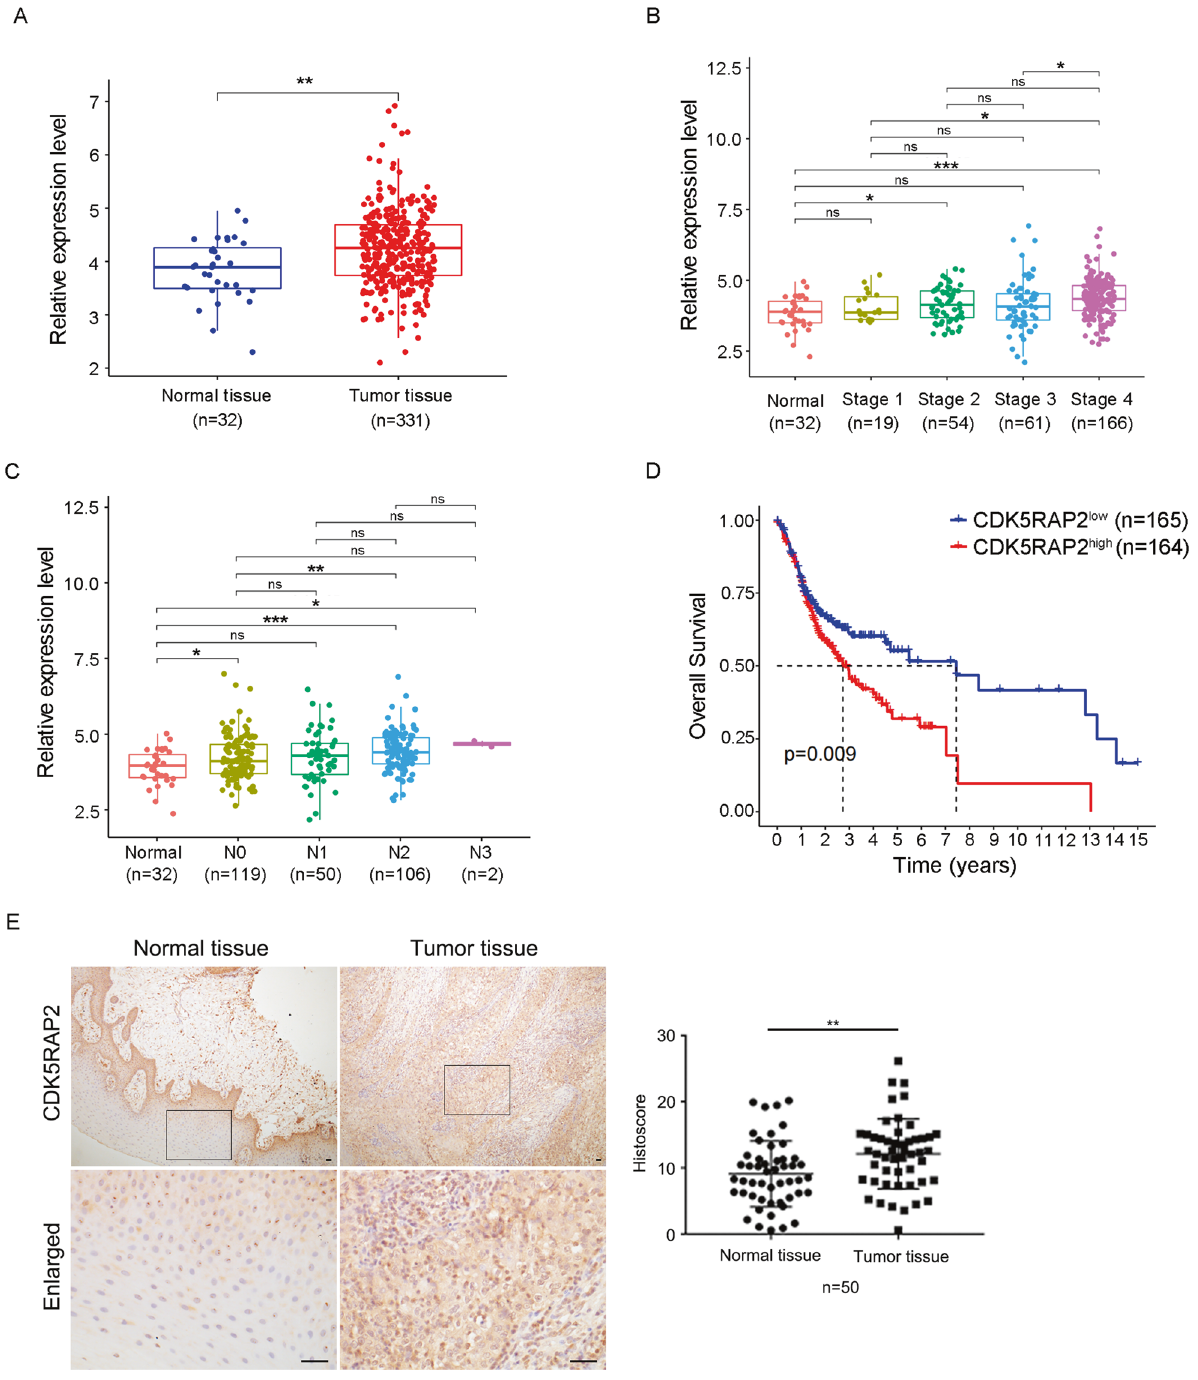
Fig. 1 CDK5RAP2 is upregulated in OSCC. A – C CDK5RAP2 expression in OSCC according to sample types A , cancer stages B , and nodal metastasis status C . D Kaplan – Meier survival analysis of TCGA-OSCC cohorts grouped by CDK5RAP2 expression level. E IHC staining of CDK5RAP2 in OSCC. Rectangular area is enlarged. CDK5RAP2 expression was quanti fi ed using Image J ( n = 50). Scale bars, 20 μ m. Data are presented as means ± SEM; ns no signi fi cance, * P < 0.05, ** P < 0.01, *** P < 0.001. stained with 0.1% crystal violet. Images were acquired under a microscope epidermal growth factor (20 ng/mL each; Novoprotein, China) and N-2 and analyzed by using image J. supplement (Gibco, CA, USA). After 7 – 10 days, we counted the tumor- spheres (diameter >50 µm) of Cal27 and HSC-3 cells. Tumorsphere formation assay shRNA-carrying stable cells were suspended and cultured at 5000 cells/well in 6-well ultra-low-attachment plates (Corning), and the culture medium was serum-free and supplemented with basic fi broblast growth factor and